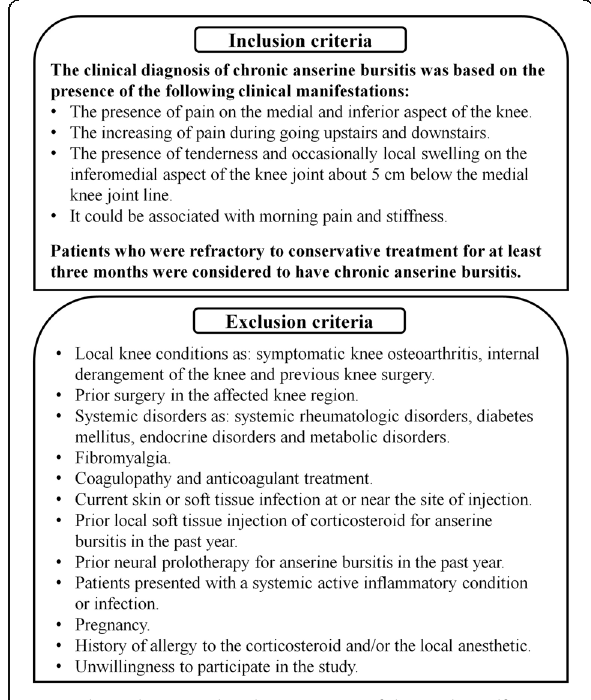
Fig. 1 The inclusion and exclusion criteria of the study (Helfenstein & Kuromoto, 2010; Yoon et al., 2005; Grover & Rakhra, 2010; Cohen et al.,